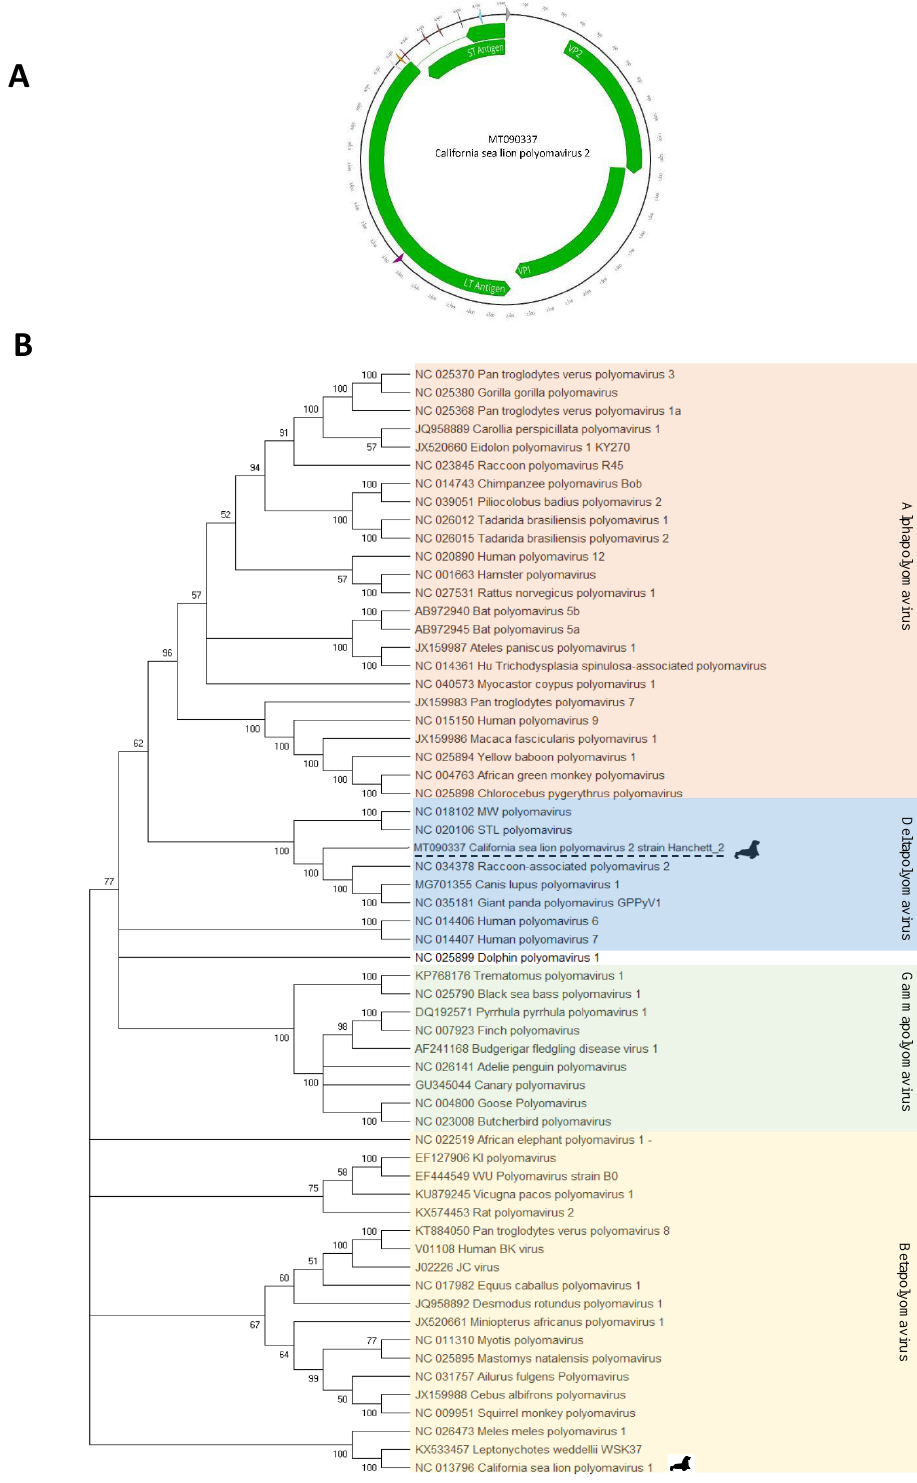
Figure 6. ( A ) California sea lion polyomavirus 2 ORF map and protein and splicing motifs as described in GenBank accession number MT090337. ( B ) Phylogenetic tree of LT was constructed using the maximum likelihood method with two substitution models: Le_Gascule_2008 model (LG) with frequencies and gamma distributed, invariant sites (G + I) model MEGA software version X. LT antigen genome potential splice donor (SD) and acceptor (SA) sites were predicted using the Human Splice Finder tool [12].